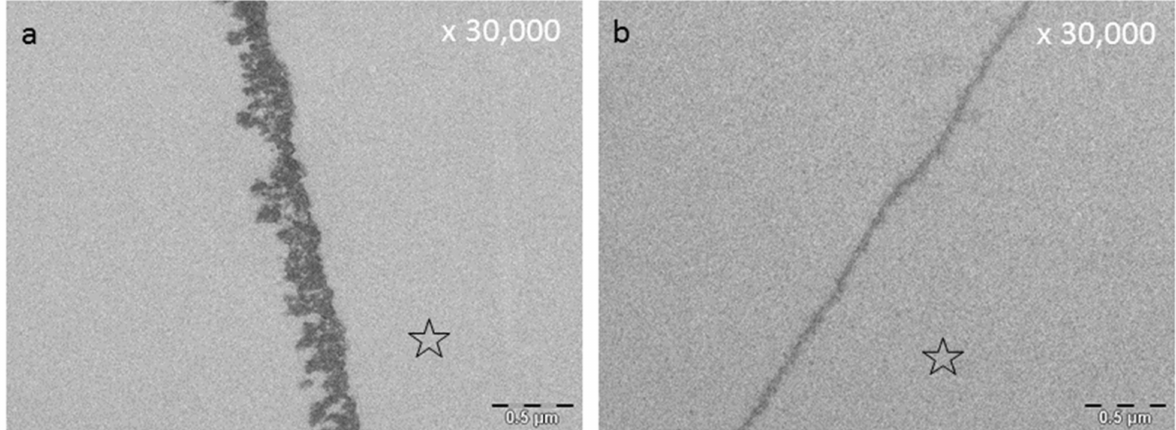
Figure 5. Both TEM images visualize the 2 h pellicle after a pellicle formation time of 1 min and rinsing with tannic acid for 10 min ( a , b ). ( b ) Sample generated after an additional treatment with HCl (pH 2.3) for 1 min in vitro (Hertel et al. (2017) [177]. In comparison, Figure 7a shows a 2 h control pellicle without rinsing. The former enamel site is marked with an